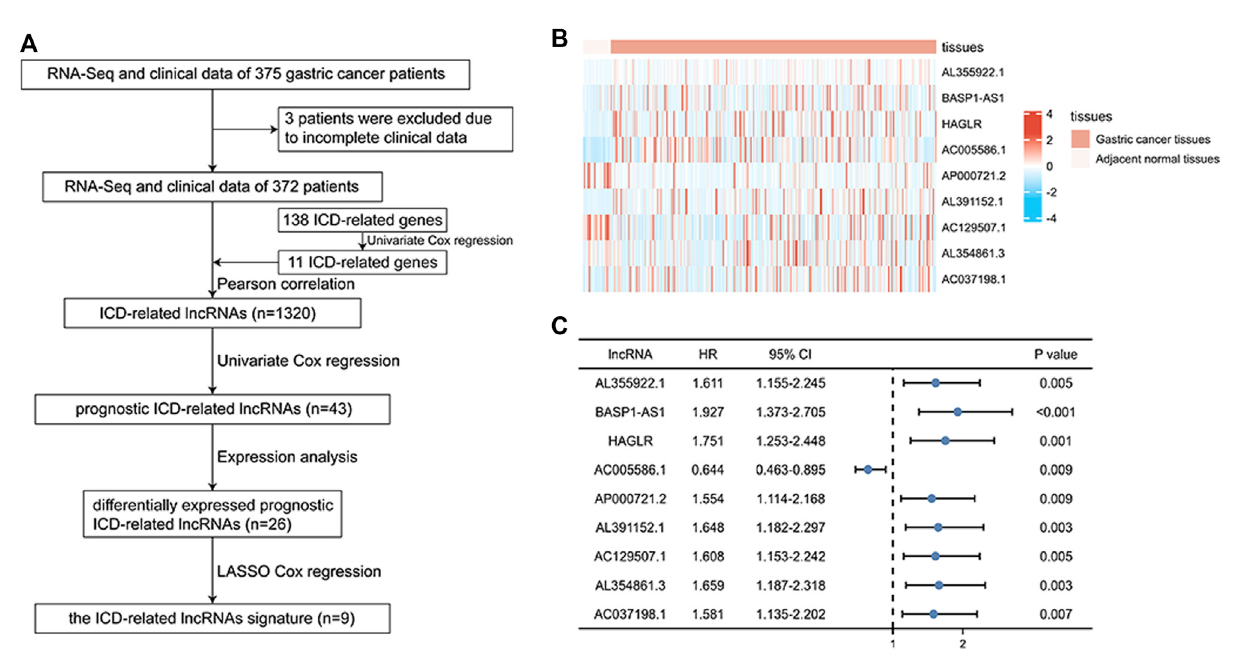
FIGURE 1 Identi fi cation of ICD-related prognostic lncRNAs between normal and gastric cancer tissue. (A) Flowchart for construction of the ICD-related lncRNA signature. (B) Heatmap of nine prognostic ICD-related lncRNAs in gastric cancer tissues and adjacent normal tissues. (C) Univariate Cox regression of nine prognostic ICD-related lncRNAs. * p < 0.05; ** p < 0.01; *** p <